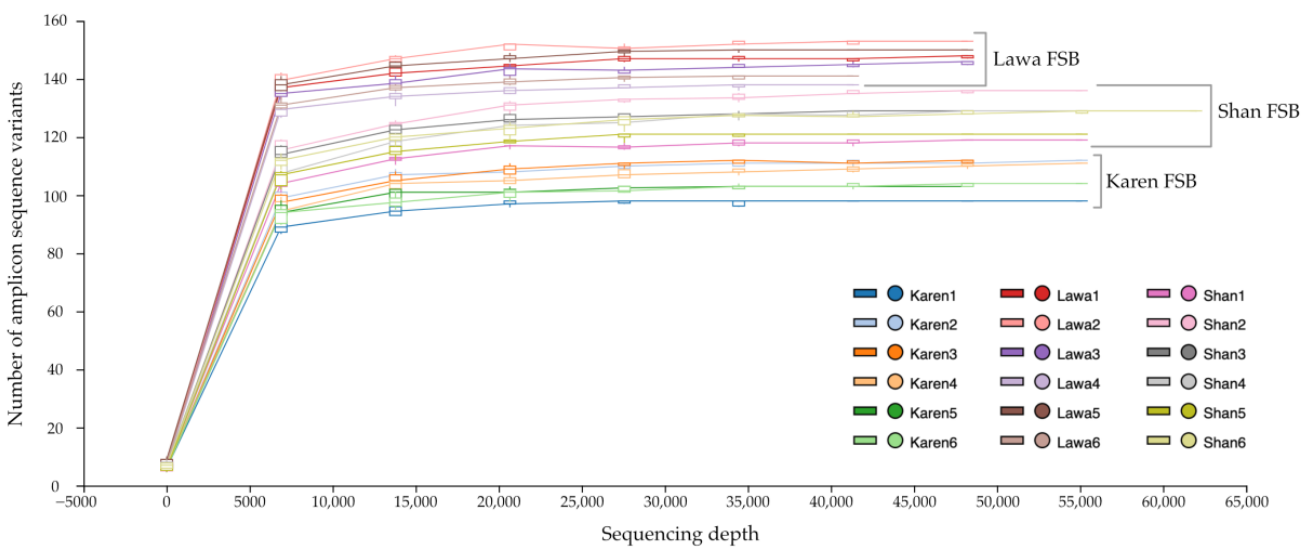
Figure 2. A rarefaction curve plot between bacterial sequencing depth and amplicon sequence variants (ASVs). The bacterial diversity of the Lawa FSB was greatest among the FSBs from the three ethnic groups, as demonstrated by the highest ASVs.